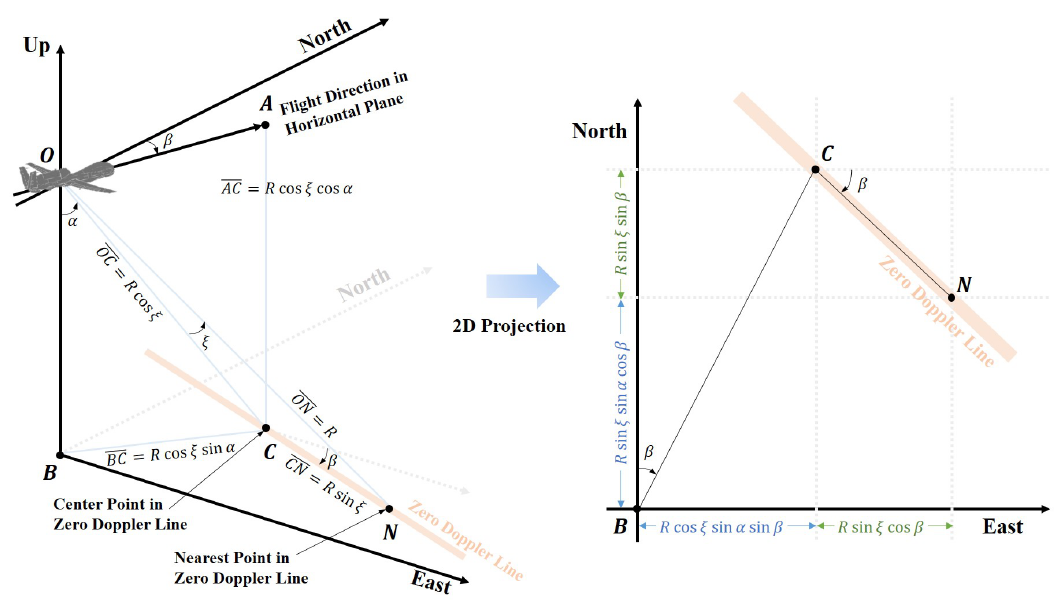
Figure 3. Relative position from the aircraft to the nearest